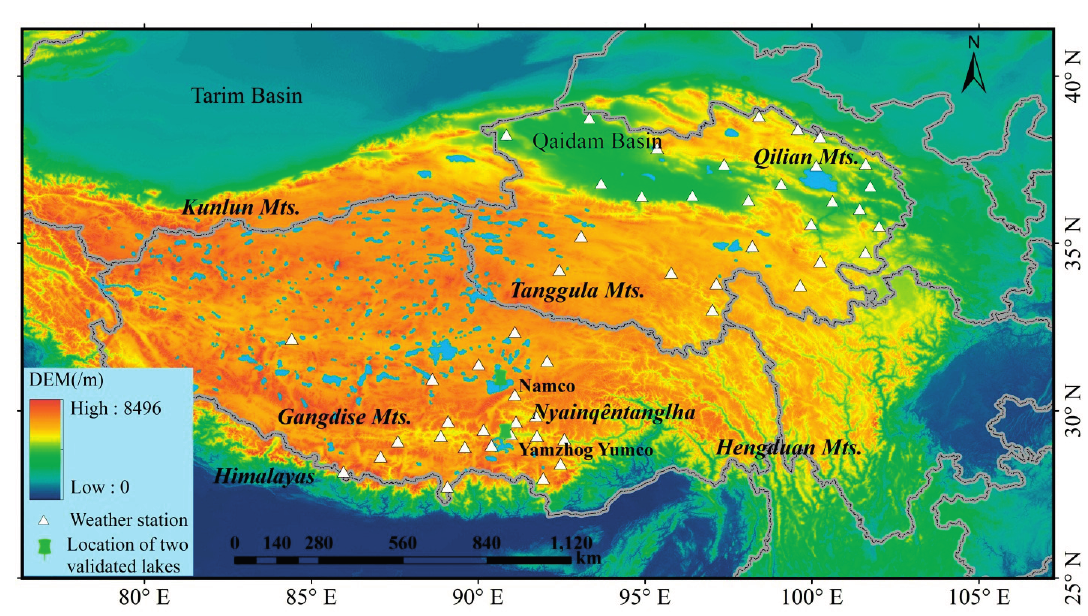
Figure 1. Map of study area showing the spatial distribution of Tibetan lakes and topographic characteristics. Digital elevation model (DEM) shown in this figure is derived from SRTM DEM dataset. The white triangles and green nail symbols represent, respectively, the locations of weather stations and validated lakes selected for this